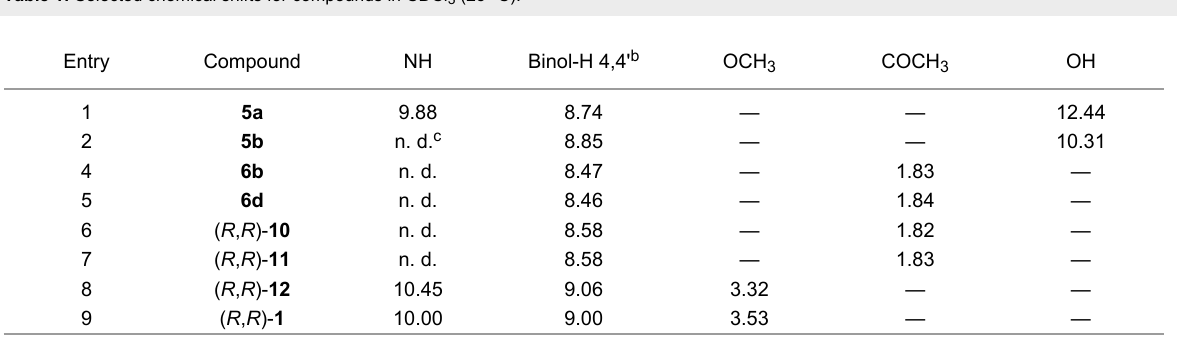
Table 1: Selected chemical shifts for compounds in CDCl 3 (25 °C). a